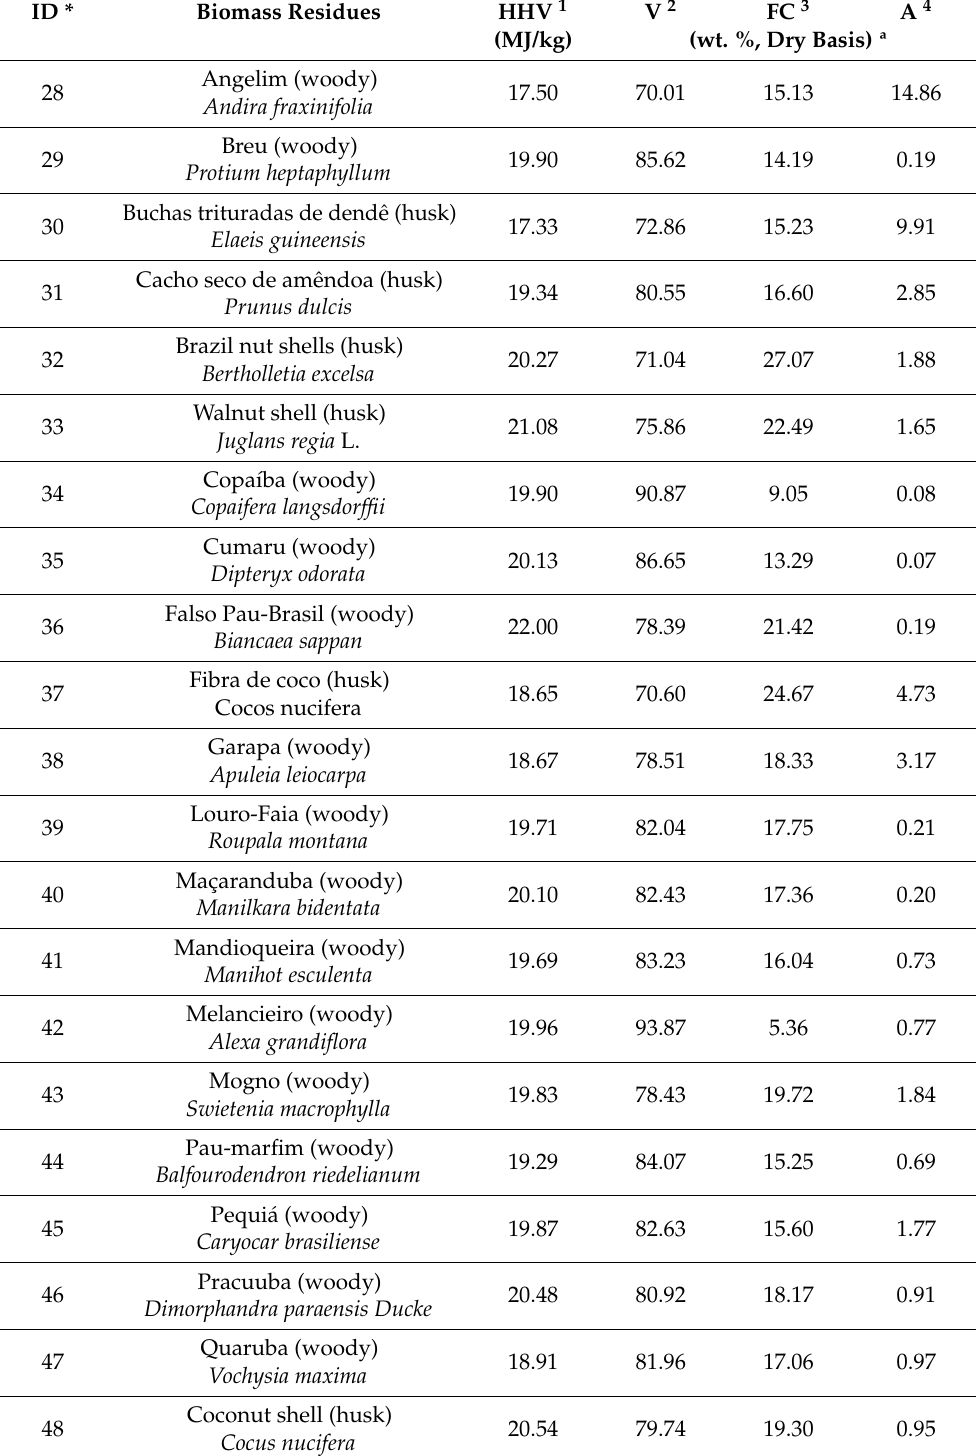
Table 4. Thermochemical data of proximate analysis for the studied biomass residues used for